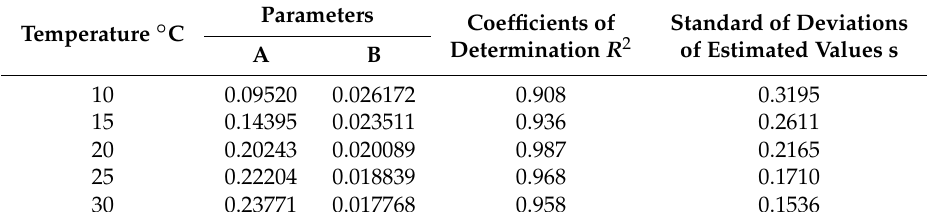
Table 3. Estimated values of parameters in the linear equation.